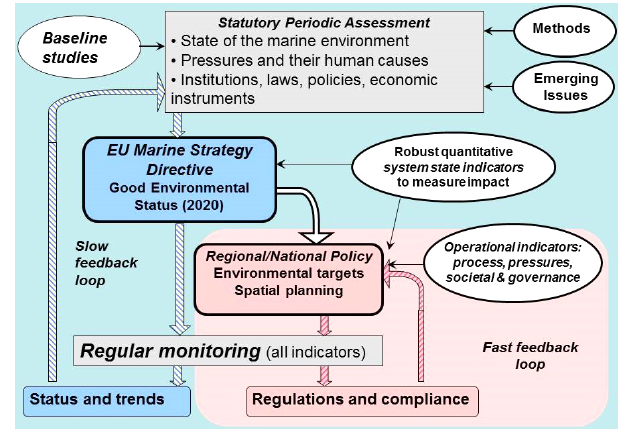
Fig. 5 . The adaptive management framework under the Marine Strategy Framework